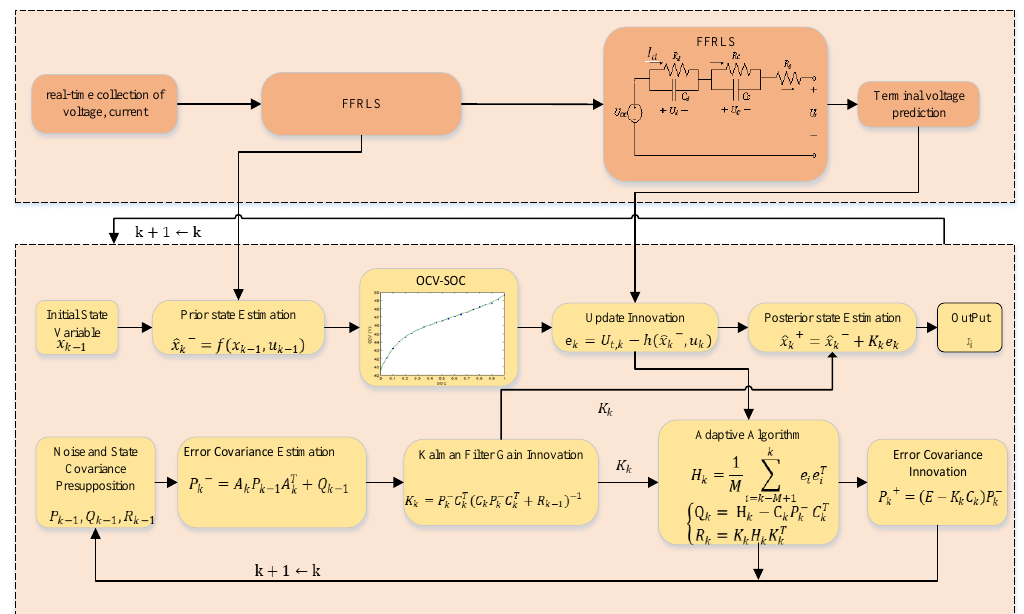
Figure 3. Flowchart of the SOC estimation algorithm.